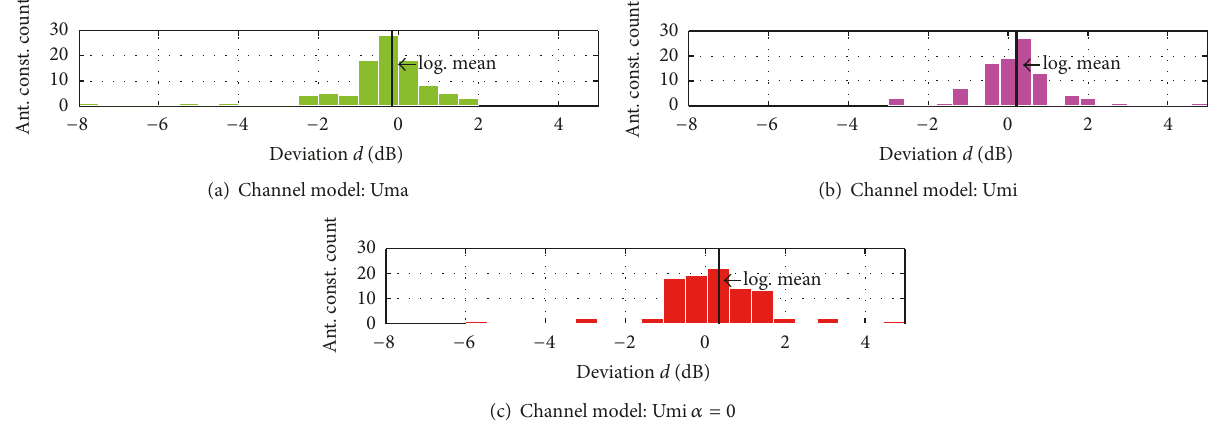
Figure 19: Distribution of the log. deviations 𝑑 between the DM and “overall” measurement results for different channel models (Uma; Umi; Umi_alpha = 0) and different base-station correlation coefficient for the smartphone Sony Xperia as UE with “Good” reference antenna.